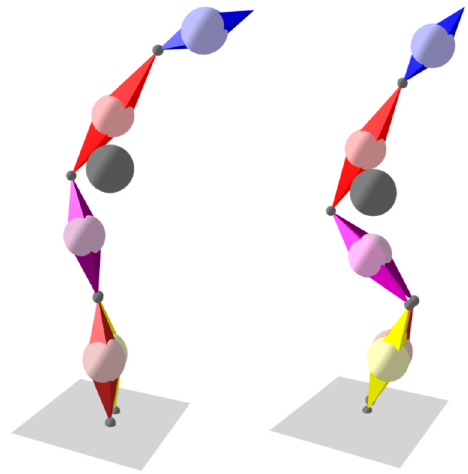
Figure 4. Calibration movements: forward lean and squat.